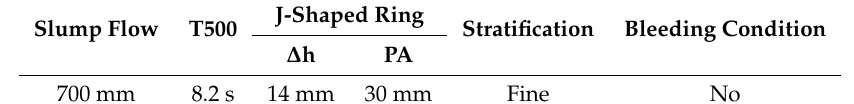
Table 12. Basic workability of the reference group (S 0 SCC).